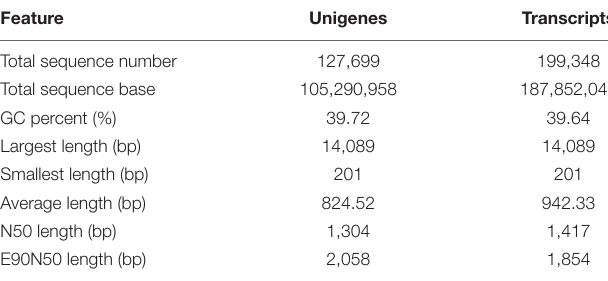
TABLE 3 | Details of the de novo transcriptome assembly.